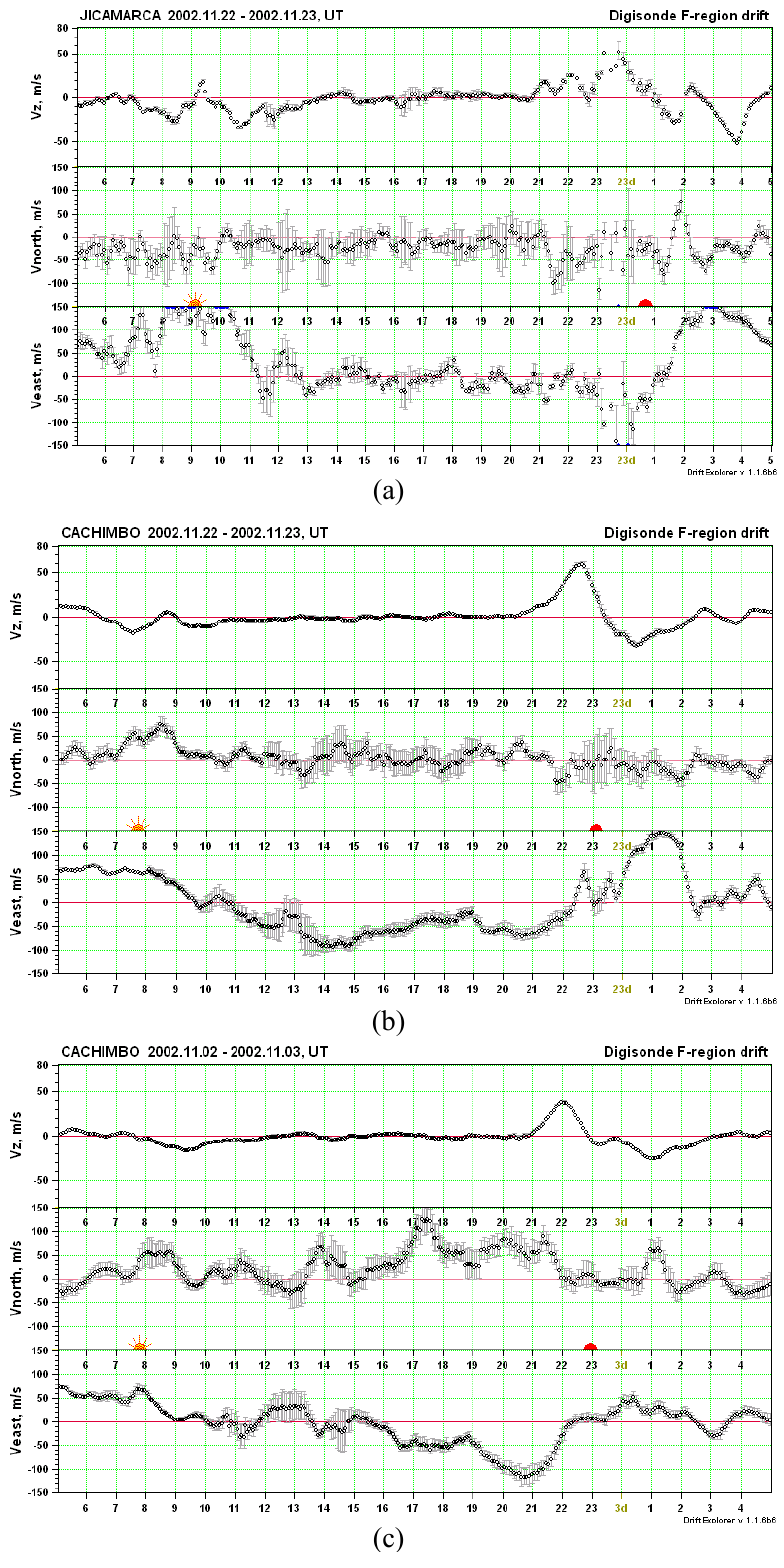
Figure 10. Vertical, meridional, and zonal drift velocities on November 22-23 (strong ESF) at a) Jicamarca and b) Cachimbo, and c) on November 2-3 (no ESF) at Cachimbo. Fig. 10. Vertical, meridional, and zonal drift velocities on 22–23 November (strong ESF) at ( a ) Jicamarca and ( b ) Cachimbo, and ( c ) on 2–3 November (no ESF) at